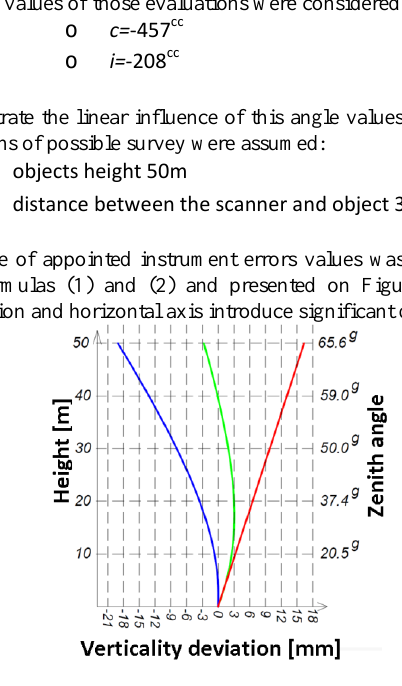
Figure 6. Verticality deviation due to researched errors (blue - collimation error influence, red - horizontal axis error influence, green - final deviation caused by both